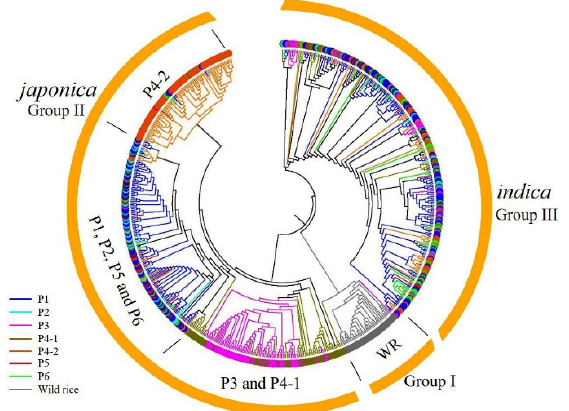
Figure 2. Neighbor ‐ joining cluster analysis of 640 rice accessions based on SSR markers. Figure 2. Neighbor-joining cluster analysis of 640 rice accessions based on SSR